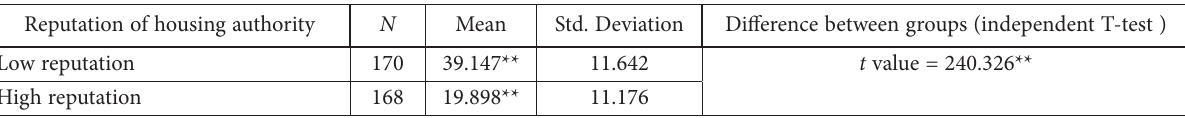
Table 9. Association between the reputation of the housing authority and the incidence of under invoicing (source: author’s calculation) Std. Deviation